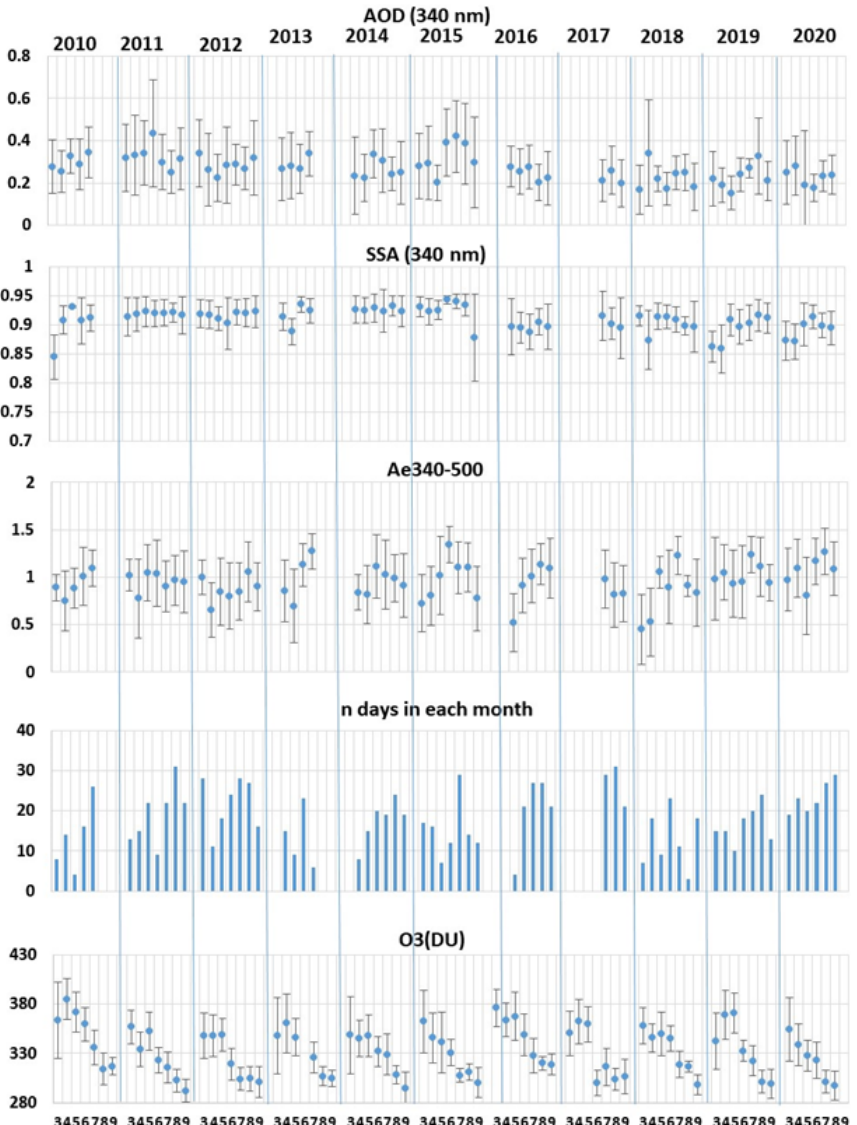
Figure 2. Monthly averages of AOD 340 , SSA 340 , Ae 340 − 500 , and total O 3 for each year from 2010 to 2020. The number of points refers to the available daily mean data used in the calculation of the aerosol parameters monthly means. Error bars are the standard deviation that, for SSA, can be lower compared to the reported 0.05 error on SSA